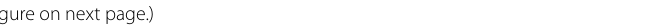
figure on next Fig. 4 Exosomal miR-335 promoted osteogenic differentiation of BM-MSCs by targeting LATS1. LATS1 mRNA ( a ) and protein ( b, c ) levels in BM-MSCs in the groups of control, induction, mDC-Exo, and mDC-Exo-NC, and mDC-Exo-miR-335I on the 7th day of culture. **P < 0.01, vs. Control; # P < 0.05, vs. mDC-Exo-NC. d Predicted binding sites for miR-335 in the 3 ′ -UTR of LATS1 (Targetscan). e The interaction between miR-335 and LAST1 3 ′ -UTR was analyzed by luciferase activity assay. **P < 0.01, vs. mimic NC. LAST1 mRNA ( f ) and protein ( g ) levels in BM-MSCs transfected with miR-335 mimics, mimic NC, miR-335 inhibitors, or inhibitor NC. *P < 0.05, **P < 0.01, vs. mimic NC; # P < 0.05, vs. inhibitor NC. h , i The protein levels of LATS1, p-LAST1, YAP, p-YAP, TAZ, and p-TAZ, j ALP activities expressed in optical density (OD) values at 520 nm, k–m Runx2 mRNA and protein levels in BM-MSCs transfected with LAST1 overexpression vector/empty vector and treated with mDC-Exo or PBS. *P < 0.05, **P < 0.01, vs. vector # P < 0.05, ## P < 0.01, vs. vector +